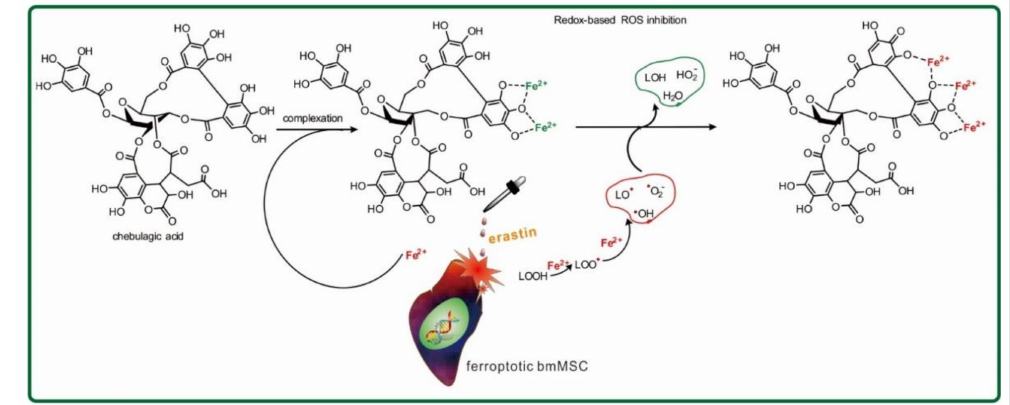
Figure 6. Illustration of antioxidant mechanisms underlying ferroptosis inhibition by chebulagic